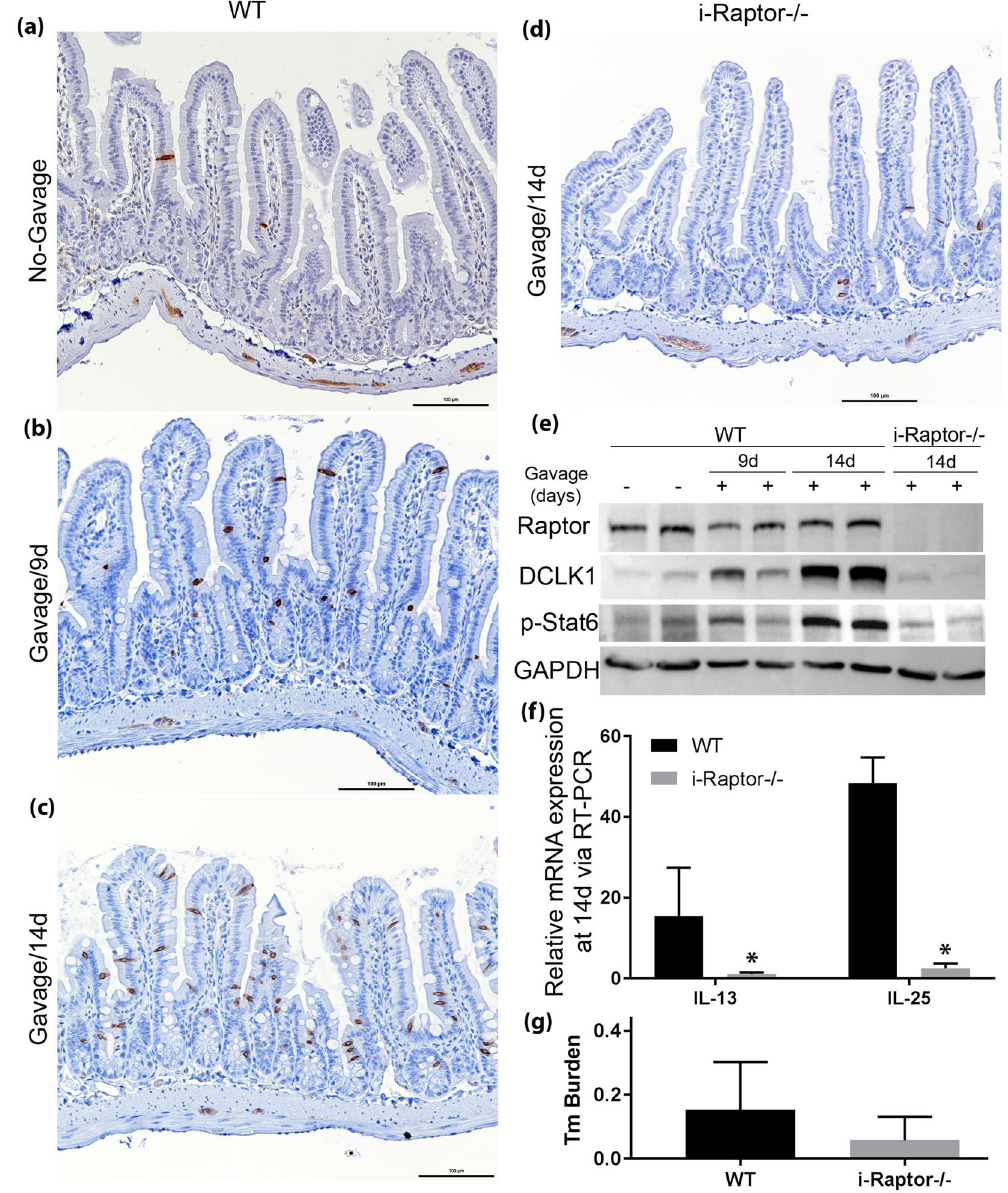
Figure 4. Raptor is required for initiating type 2 immune response after Tm infection. Vilin-Cre ER ( − ); Raptor ( f / f ) (WT, n = 6) and Vilin-Cre ER ( + ); Raptor ( f / f ) ( i - Raptor − / − , n = 5) mice were injected intraperitoneally with TAM for 3 consecutive days, fed with liquid diet for 7 days to eliminate Tm infection and reinfected via gavage with Tm containing feces. The small intestine was removed at 9 or 14 days after gavage. ( a – d ) Representative IHC shows tuft cells in brown using anti-DCLK1 antibody. ( e ) Western blot analysis of DCLK1 protein expression and Stat 6 phosphorylation after Tm re-infection in mice. GAPDH was used as loading control. ( f ) Real-time PCR quantification of IL-25 expression in enterocytes and IL-13 expression in lamina propria. ( g ) Tm burden quantified from stools collected at 14 days after Tm gavage. Mean ± SD is shown. Student’s t test ( * p <